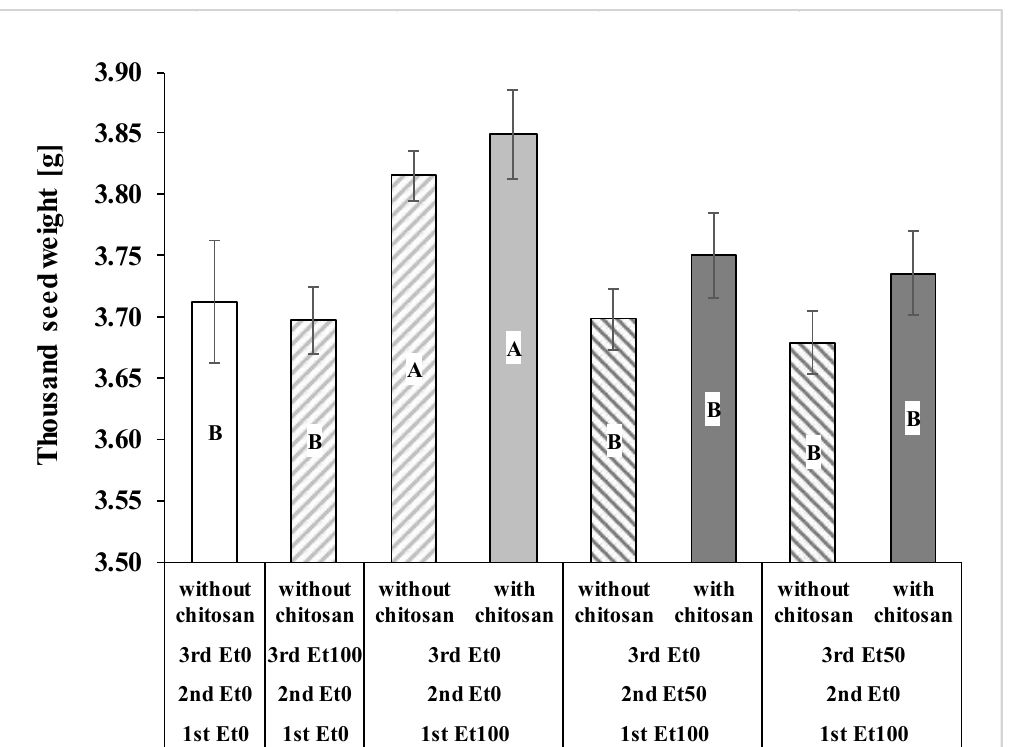
Figure 4. Role of the Ethylene [Et] application at full dose [100%, indicated as Et100] or half dose [50%], indicated as Et50 or no application [0%, indicated as Et0] during the first, second and third (1st, 2nd, and 3rd, respectively) occasion as shown in Figure 1) and chitosan application on the thousand seed weight of onion growing under rainfed conditions. Moment of ethylene application included an early, mid, and late applications indicated as first, second and third (1st, 2nd, and 3rd, respectively) occasions in the figures. Amount of ethylene application included 100% recommended rate (in the 1st or 3rd occasions) or 100% in the 1st + 50% in either the 2nd or 3rd occasions. Chitosan application was performed in ‘Treat” including a 100% application in the 1st occasion (irrespective of the further 50% application in the 2nd or 3rd occasions) compared to a non-chitosan treatment. A control with no chitosan and no ethylene was included. Since Treat, but not Chit(Treat), showed a p < 0.05, p-differences of the LSmeans were computed and separated by a conservative Tukey–Kramer grouping at 5%. Letters displayed were thus rebuilt from the “Treat” LSmeans as shown in Supplementary Material Table S1. Bars with a letter in common should not be considered different, according to Tukey–Kramer. Data are arithmetic means and standard errors ( n = 4).